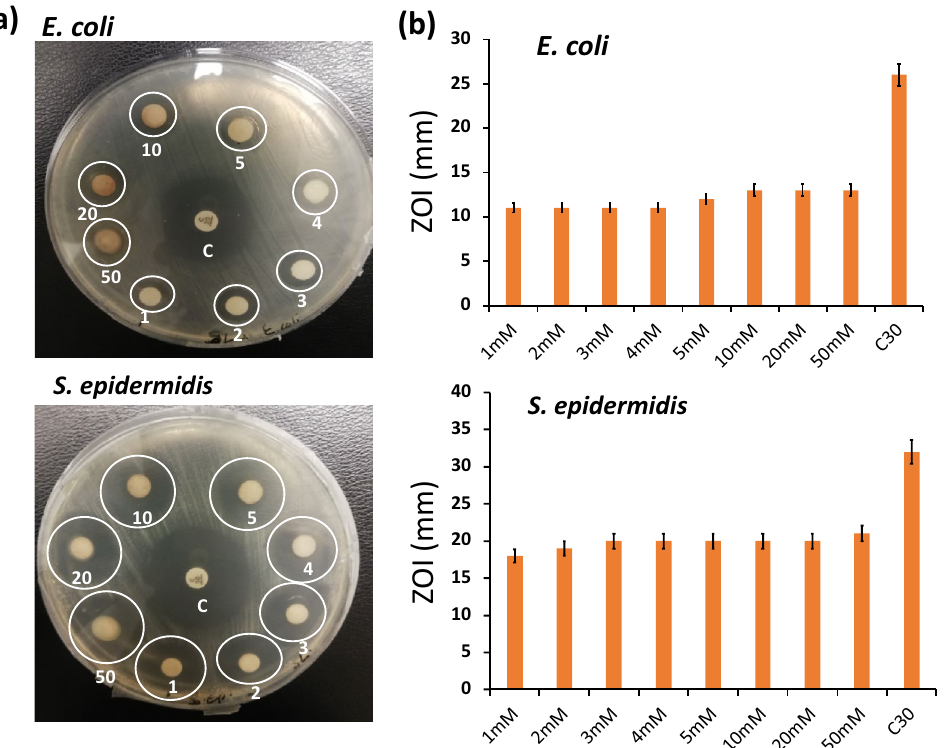
Figure 4. Antibacterial activity of SL-SpNPs on E. coli and S. epidermidis . ( a ) Antibacterial efficacy analysis was performed by using Kirby Bauer (disc diffusion) method. A 20 µl of eight (SL-SpNPs) samples were used i.e., 1 mM, 2 mM, 3 mM, 4 mM, 5 mM, 10 mM, 20 mM and 50 mM whereas antibiotic i.e., (chloramphenicol, C was used as a positive control in experiments. Zones of inhibition (ZOI) around the discs are evident for the effectiveness of SL-SpNPs against the bacterial pathogens. ( b ) ZOI were calculated by using a scale in mm and their mean values are shown by bar plots (error bars show standard deviation). Experiments were performed in